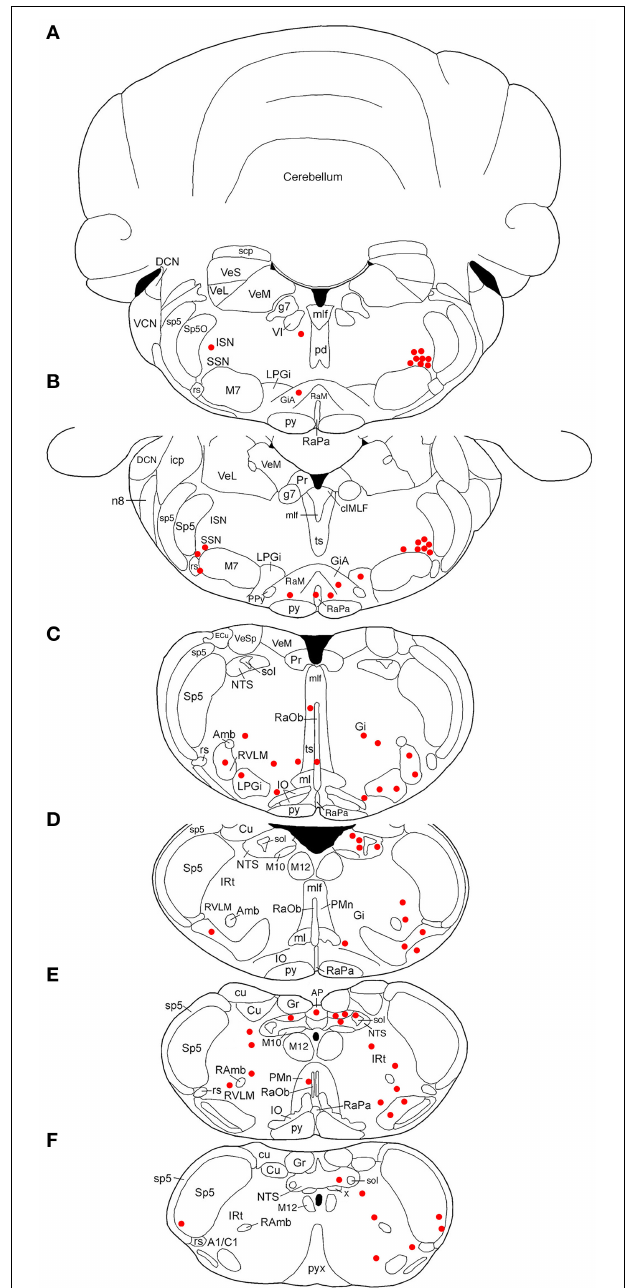
FIGURE 3 | Line drawing schematics of coronal sections through the caudal pons and medulla, based on the rat atlas of Paxinos and Watson (2009), showing the distribution of PRV + neurons in RF73, in which the PRV injection was well confined to the choroid and yielded extensive higher-order labeling. Each filled red circle represents one PRV + neuron. The images progress from most rostral at the top (A) to most caudal at the bottom (F) . For full structure names see list of